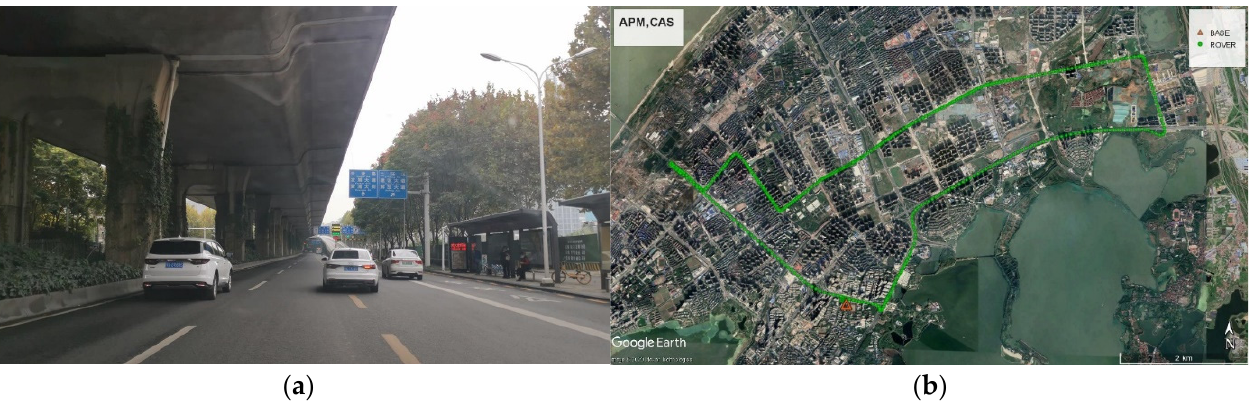
Figure 16. Kinematic vehicle experiment in the complex urban environment: ( a ) indicative test scene; ( b ) test route.